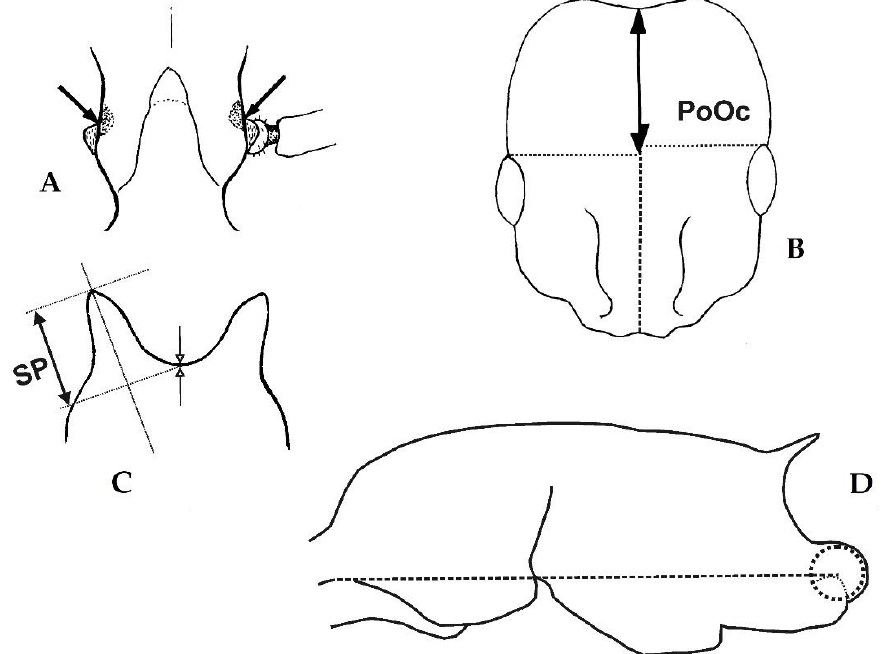
of postocular distance PoOc to correct for head asymmetries; ( C ) Measuring spine length in dorsofrontal view; ( D ) The dotted line marks the longitudinal axis of mesosoma in lateral view.